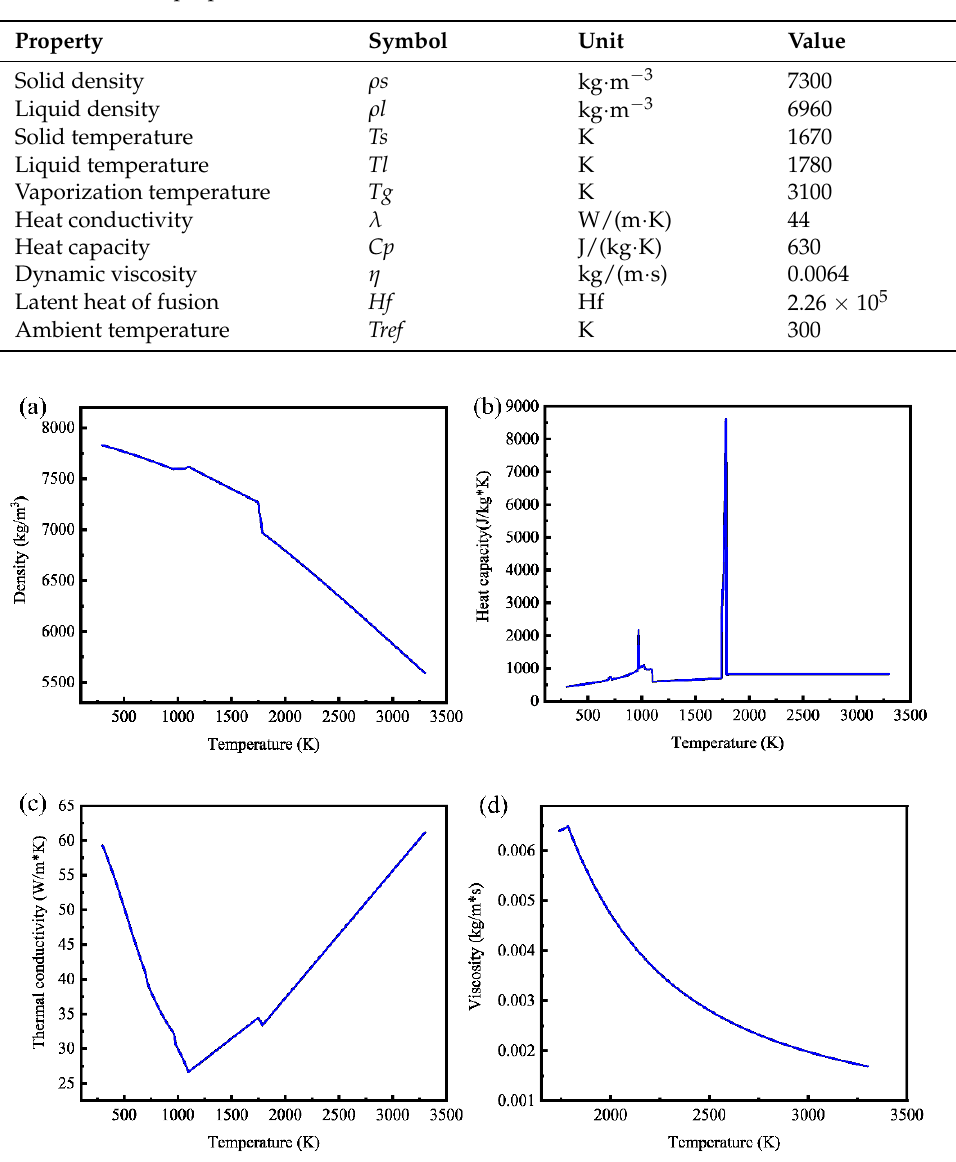
Figure 3. Thermophysical properties of AH36 steel: ( a ) density, ( b ) heat capacity, ( c ) thermal conductivity, ( d ) viscosity.